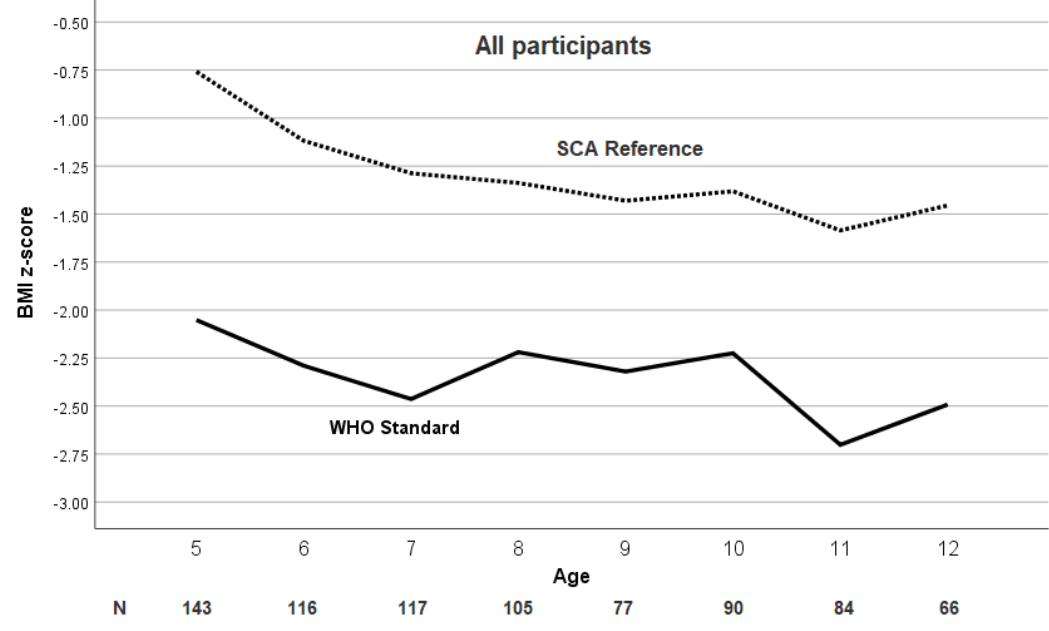
Figure 3. Age trend of BMI Z -score in children with SCA using the WHO and SCA reference populations. The mean BMI Z -score in children (5 – 12 years of age) with sickle cell anemia (SCA) in Nigeria is consistently greater based on the SCA-specific growth reference at each age compared to the WHO growth reference.